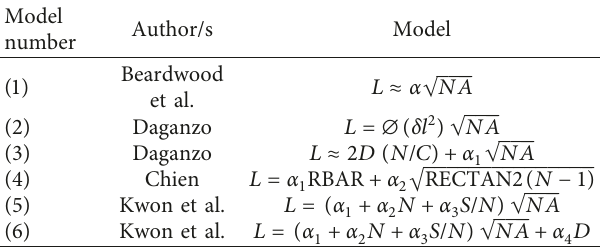
Table 1: Proposed models in previous